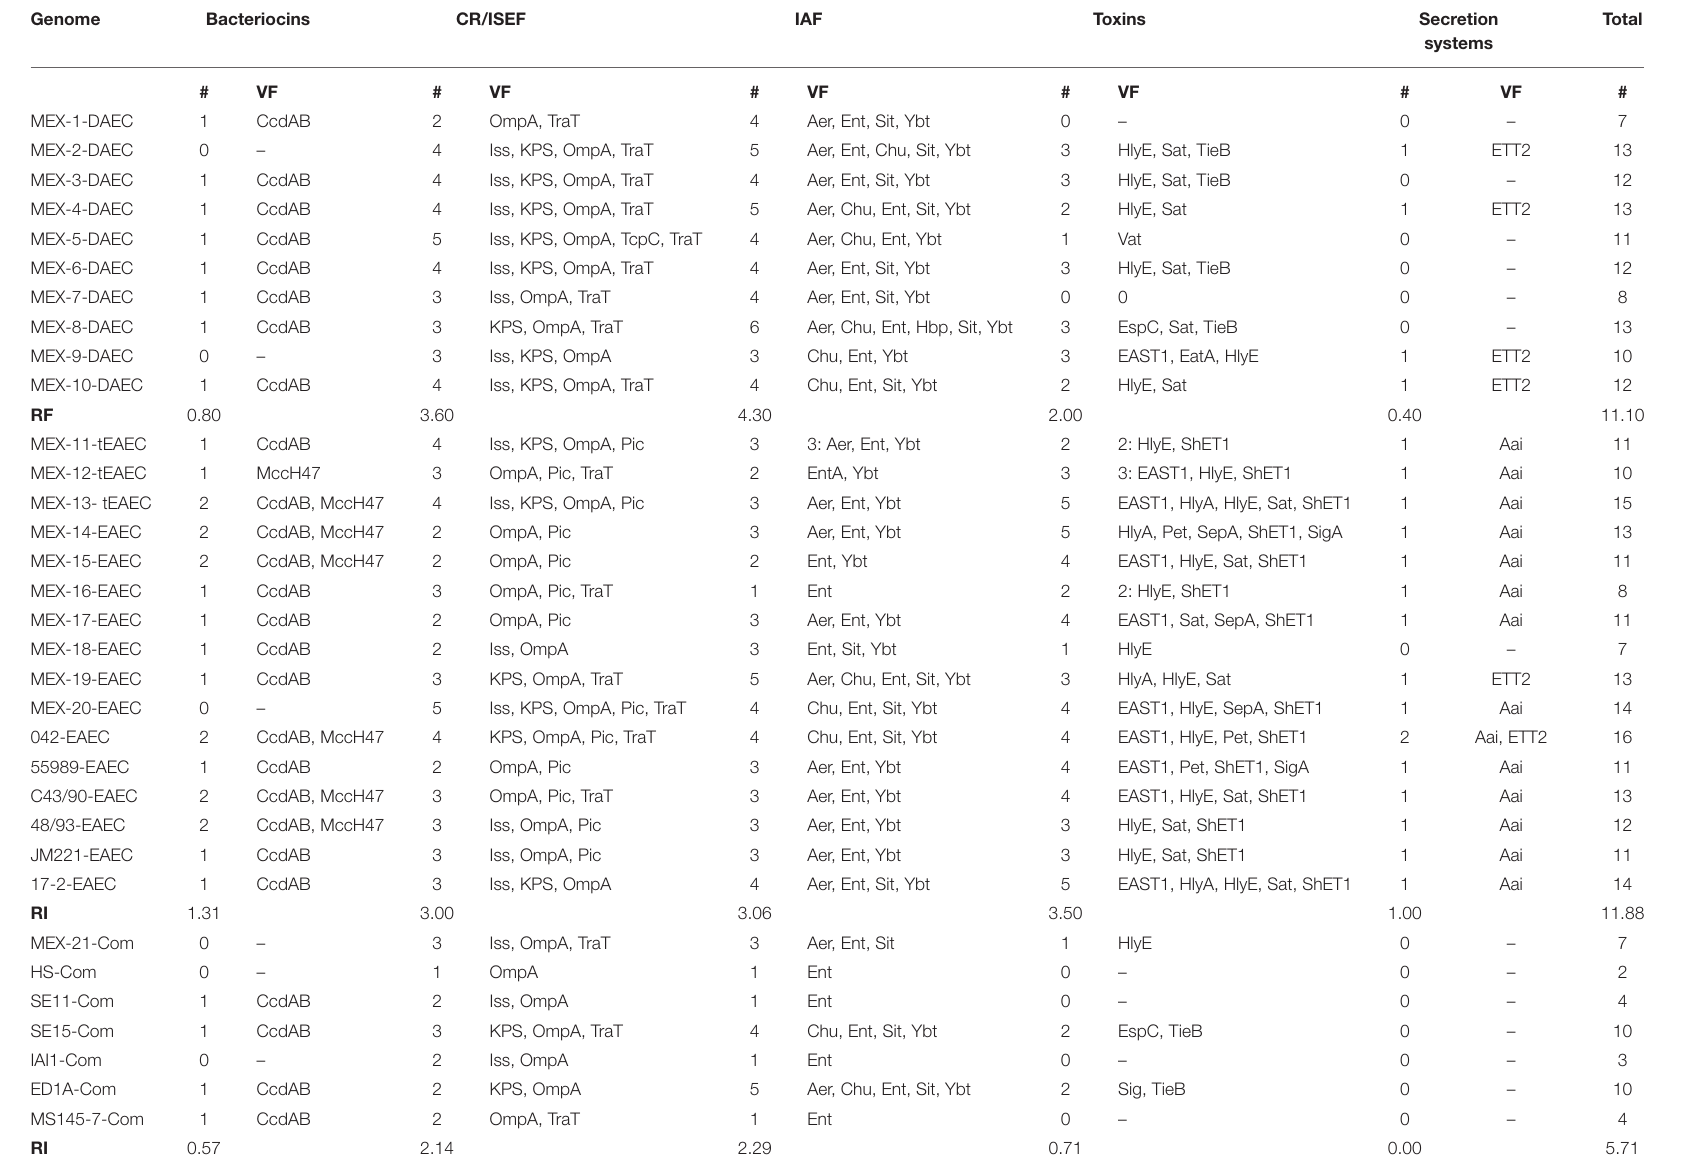
TABLE 2 | Distribution of groups of virulence factors among DAEC, EAEC, and commensal E. coli genomes.